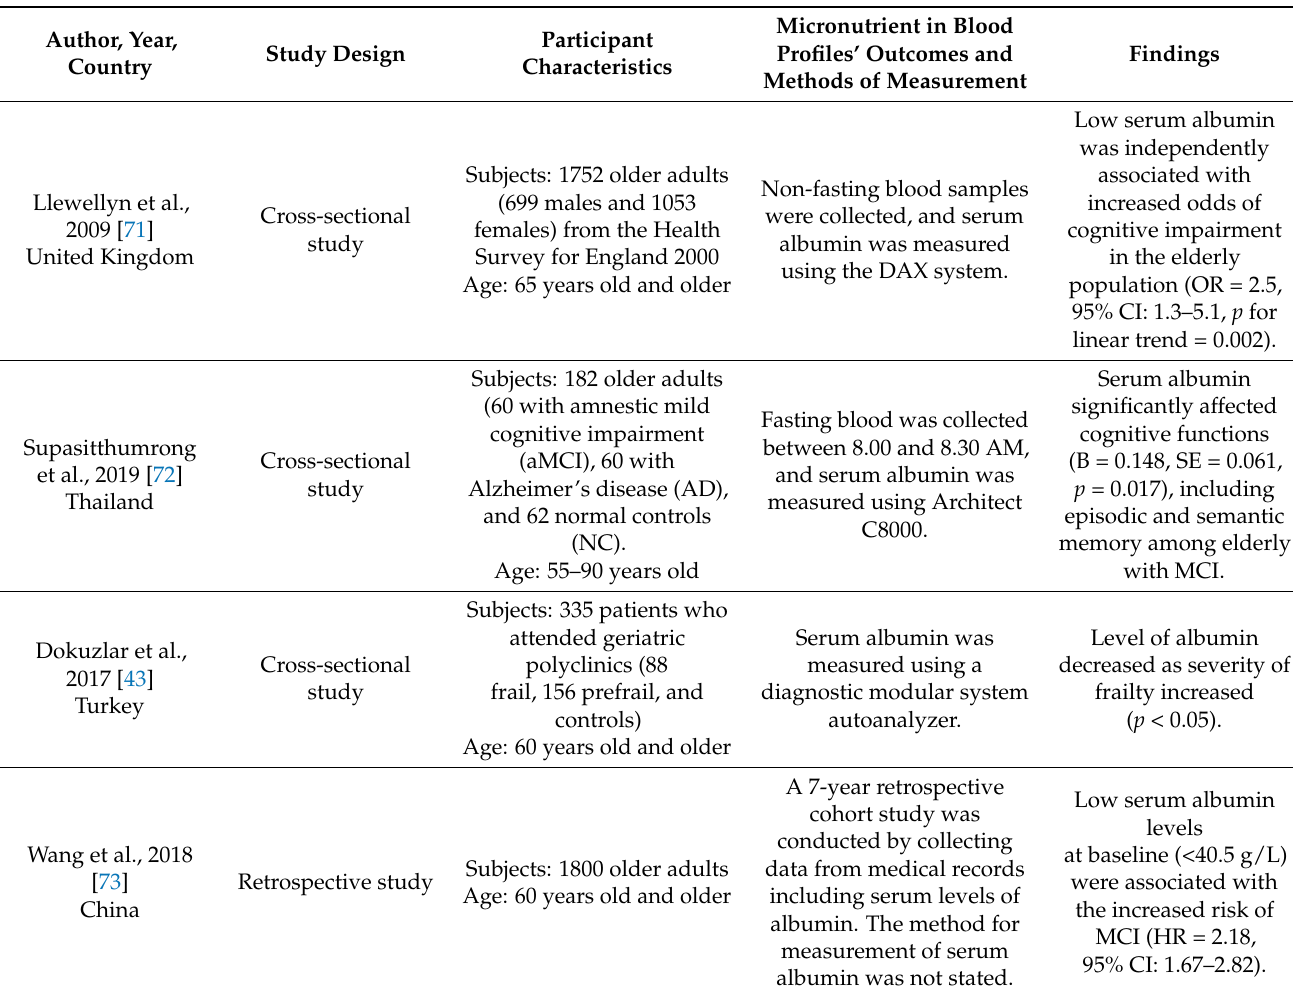
Table 6. Summary of studies evaluating the association between protein with mild cognitive impair- ment, frailty, and cognitive frailty involved in the